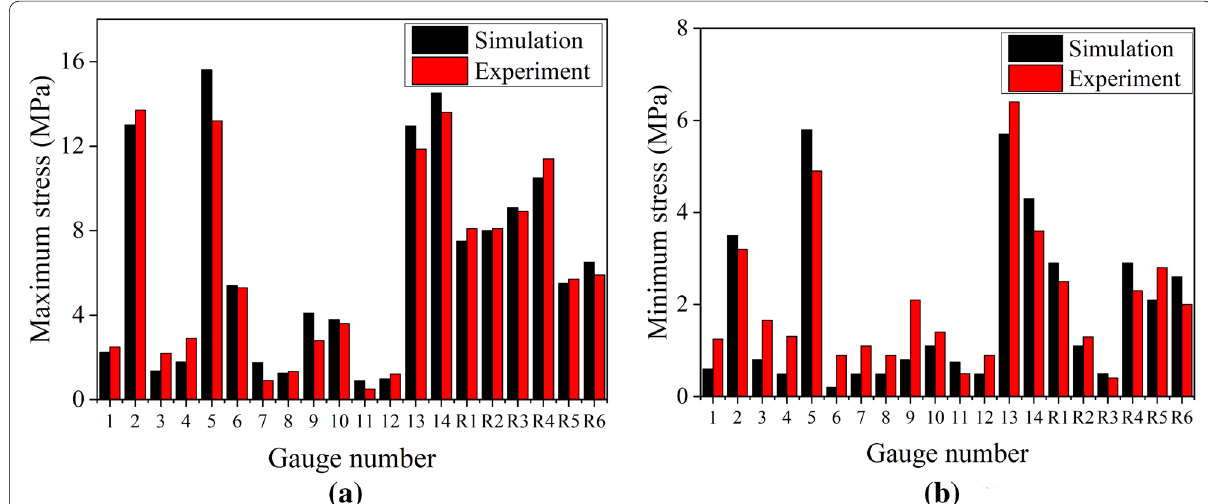
Figure 9 Stress comparisons between FE simulation and fatigue test: a maximum stress; b minimum stress in one load cycle